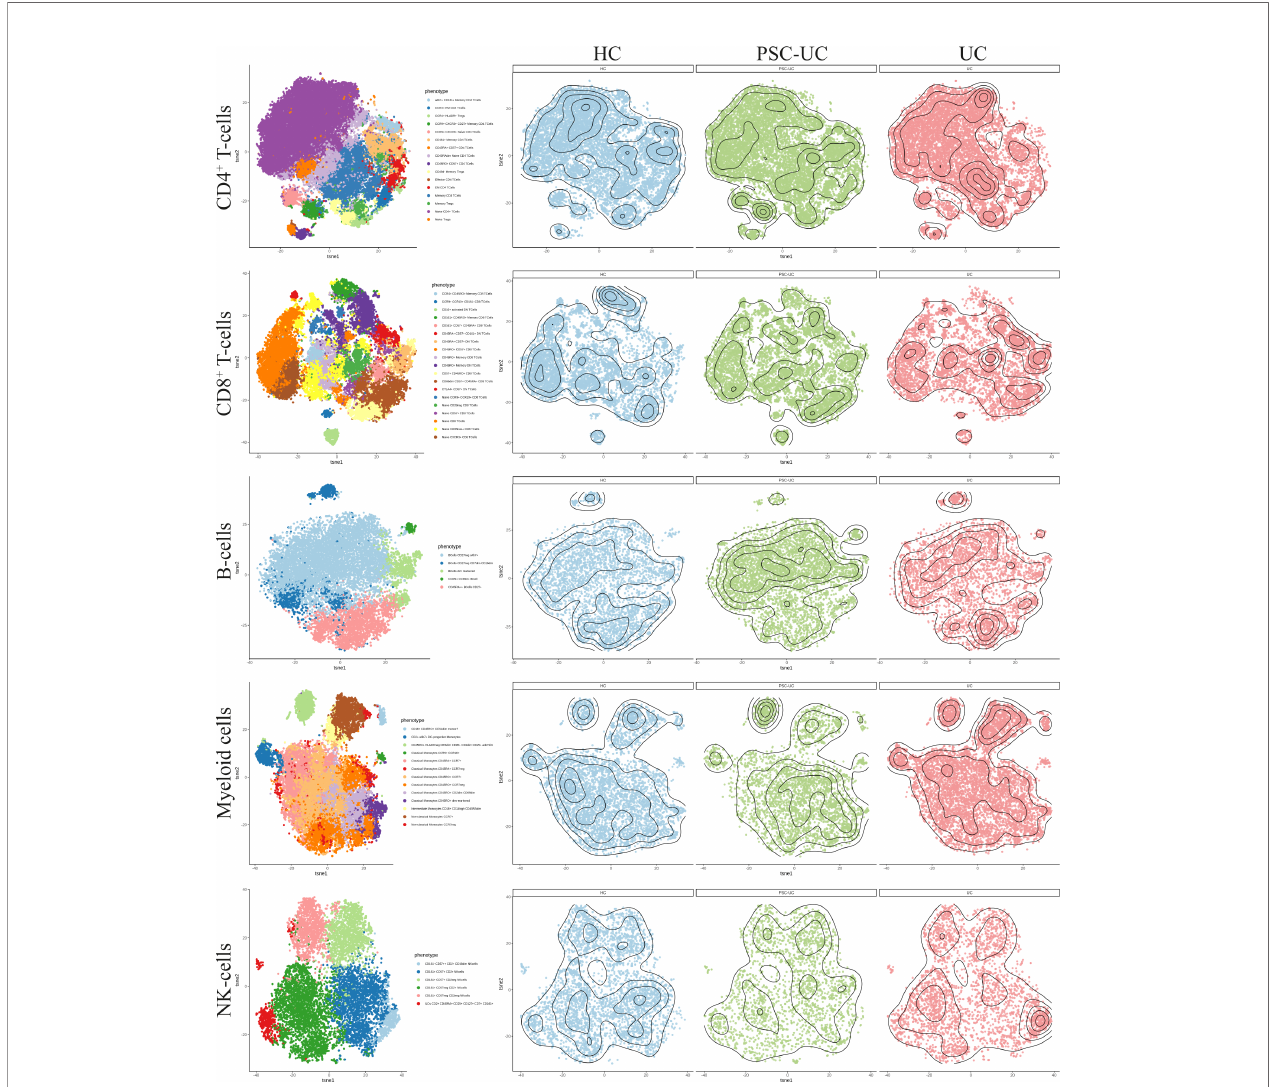
FIGURE 5 | High dimensional mass cytometry (cyTOF) analysIs reveals that peripheral blood cell distribution is comparable between patients with PSC-UC, UC and HC. The lineages CD4 + T-cells, CD8 + T-cells, B-cells, myeloid cells and NK cells were clustered for PSC-UC, UC and HC and color coded visualized using vISNE, a visualization tool for high dimensional single cell data based on the t Distributed Stochastic Neighbor Embedding (t-SNE)